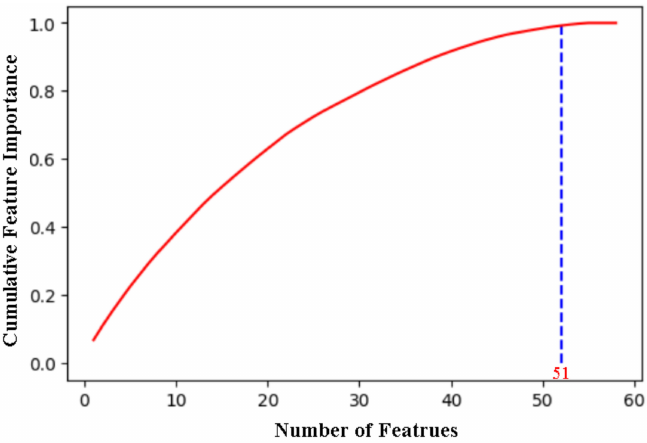
Figure 5. Overall cumulative importance curve.